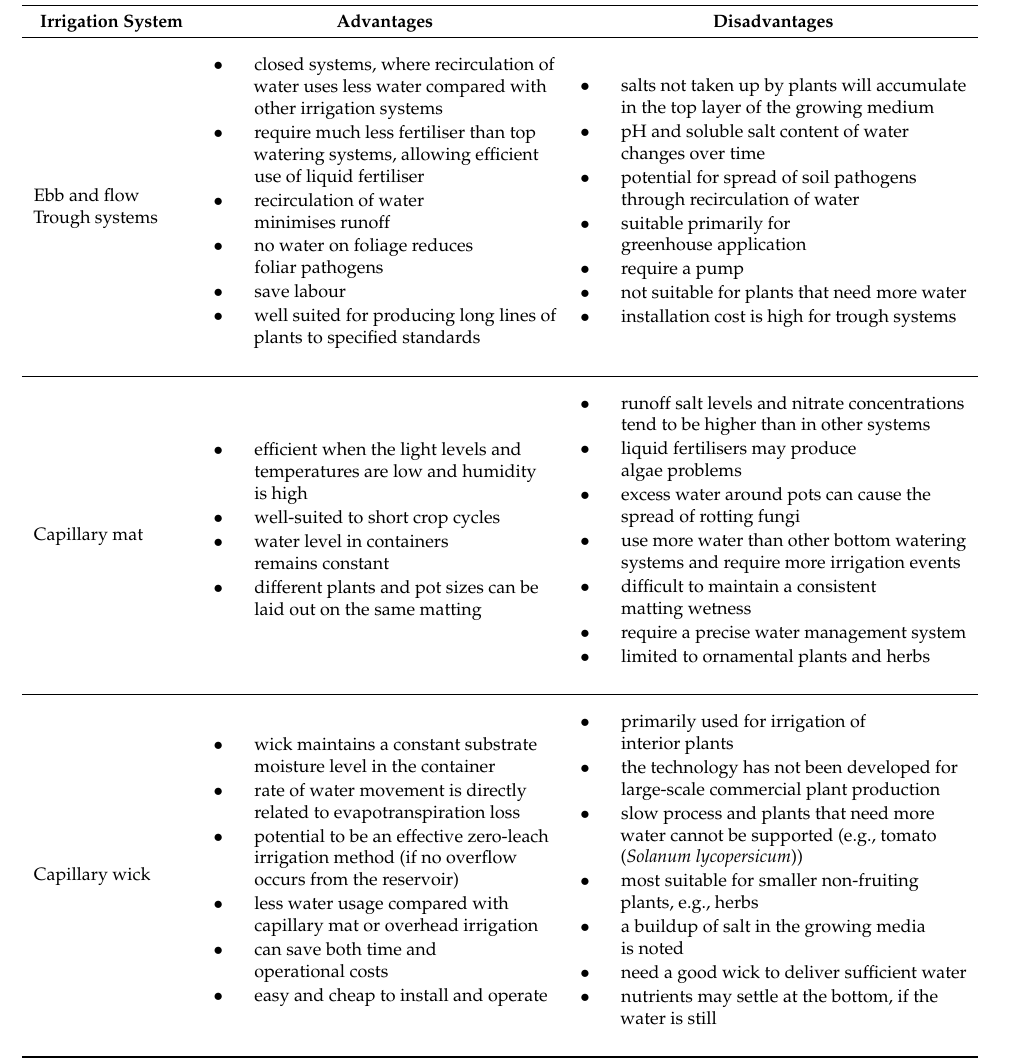
Table 2. Advantages and disadvantages of commonly practiced subirrigation systems